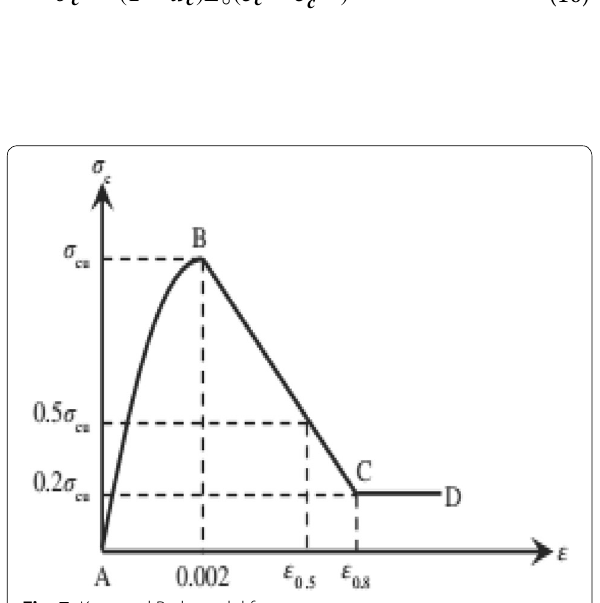
Fig. 7 Kent and Park model